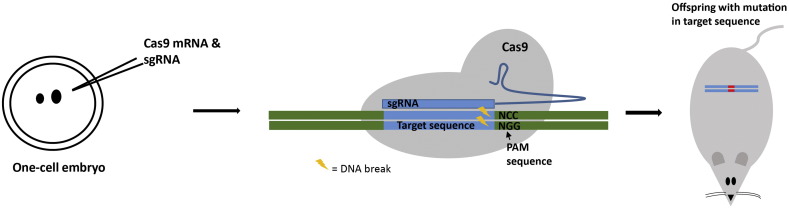
Producing a knock-out mutation. The production of mice with a knock-out mutation produced through the non-homology end-joining (NHEJ) repair mechanism. One-cell embryos, isolated from a donor mouse, are microinjected with Cas9 mRNA and single guide RNA (sgRNA) specific to the target DNA. The mechanism of the system is illustrated, with the sgRNA binding to the target genomic DNA (blue region), guiding the Cas9 enzyme (in grey) to the region which then produces the double strand break. The double strand break is repaired by NHEJ, which could include insertions, deletions or frameshift mutations, resulting in gene disruption. Embryos are transferred to a pseudopregnant host mouse and offspring are genotyped to test for the presence of the knock-out mutation.